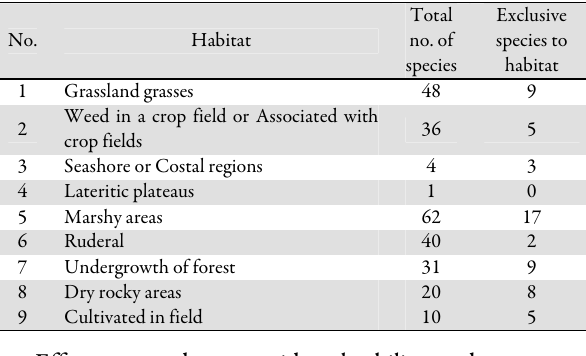
Tab. 1. Total number of species per habitats associated with grassland and total number of species exclusive to